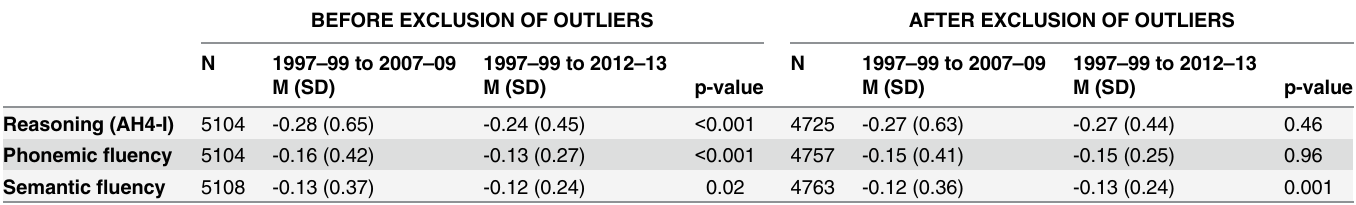
Table 4. Mean annual change over the first 3 waves (1997/99 to 2007/09) and over all 4 waves (1997/99 to 2012/13) before and after exclusion of